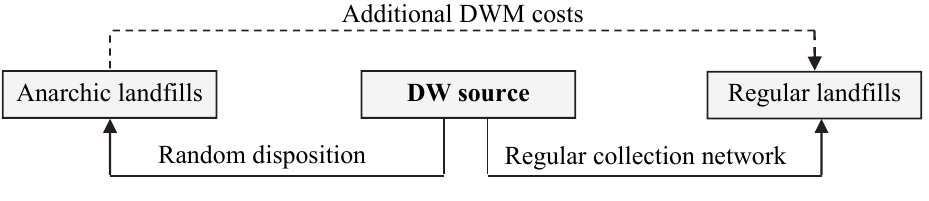
Fig. 3. DWM network in